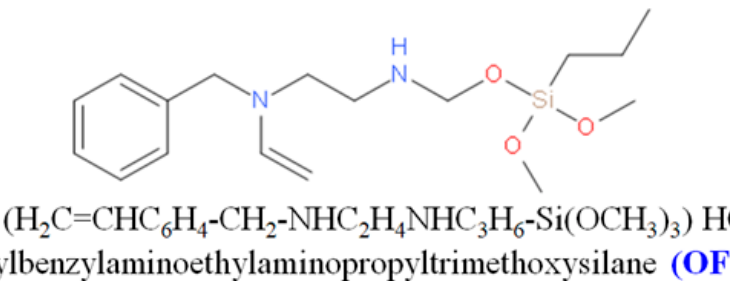
Figure 1. Chemical structure of Silanes.